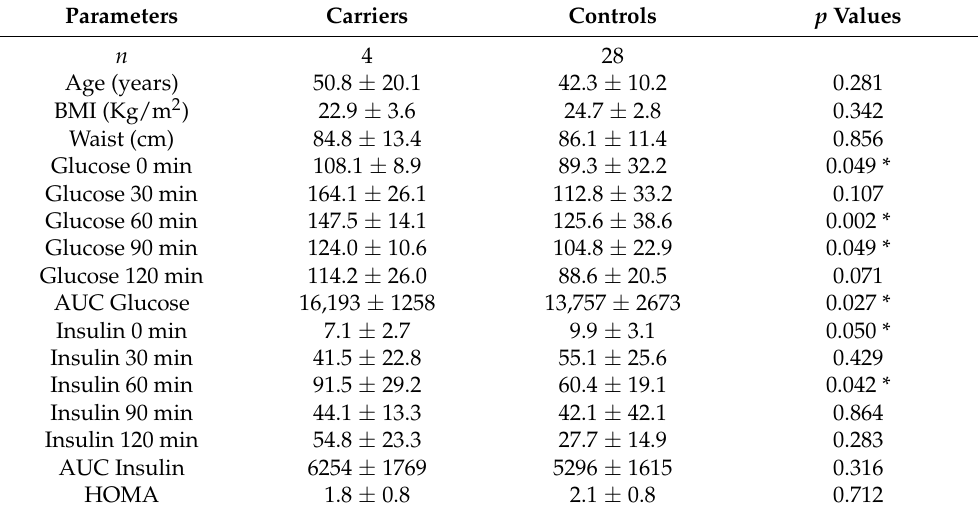
Table 2. Results of